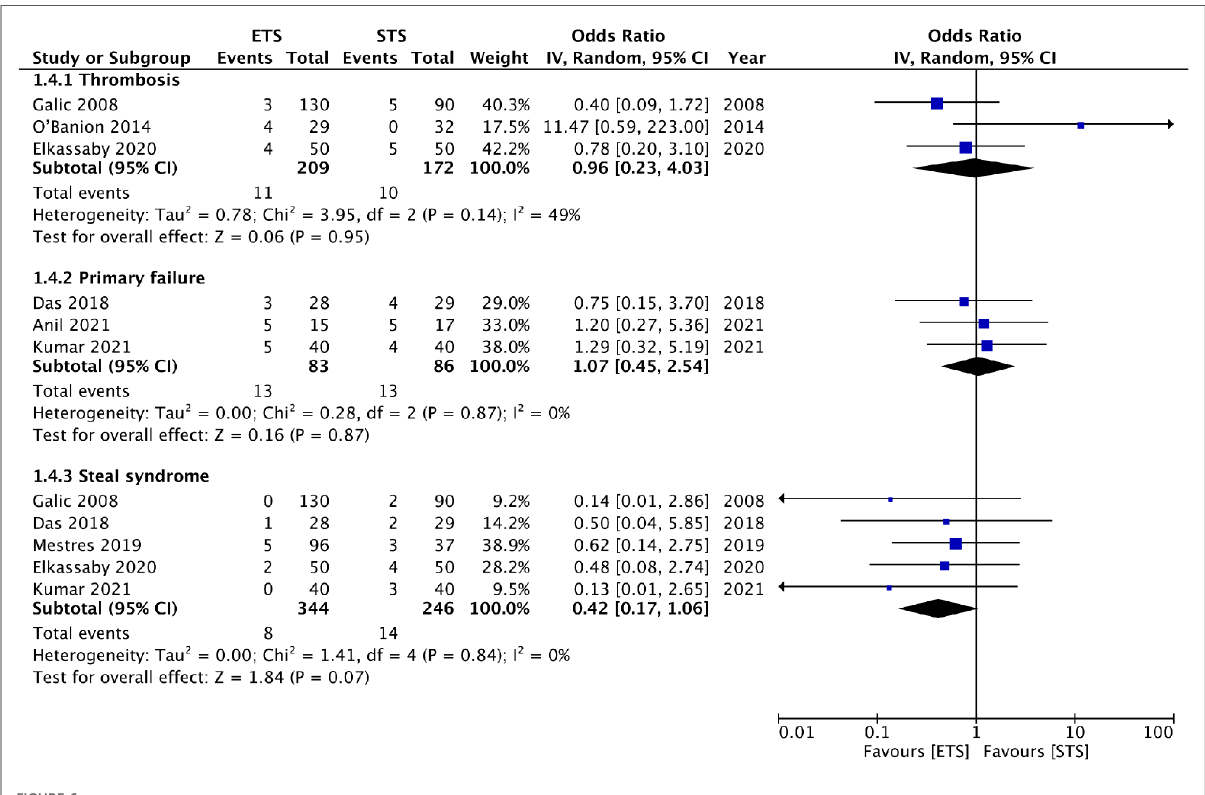
FIGURE 6 Meta-analysis of complications between ETS and STS